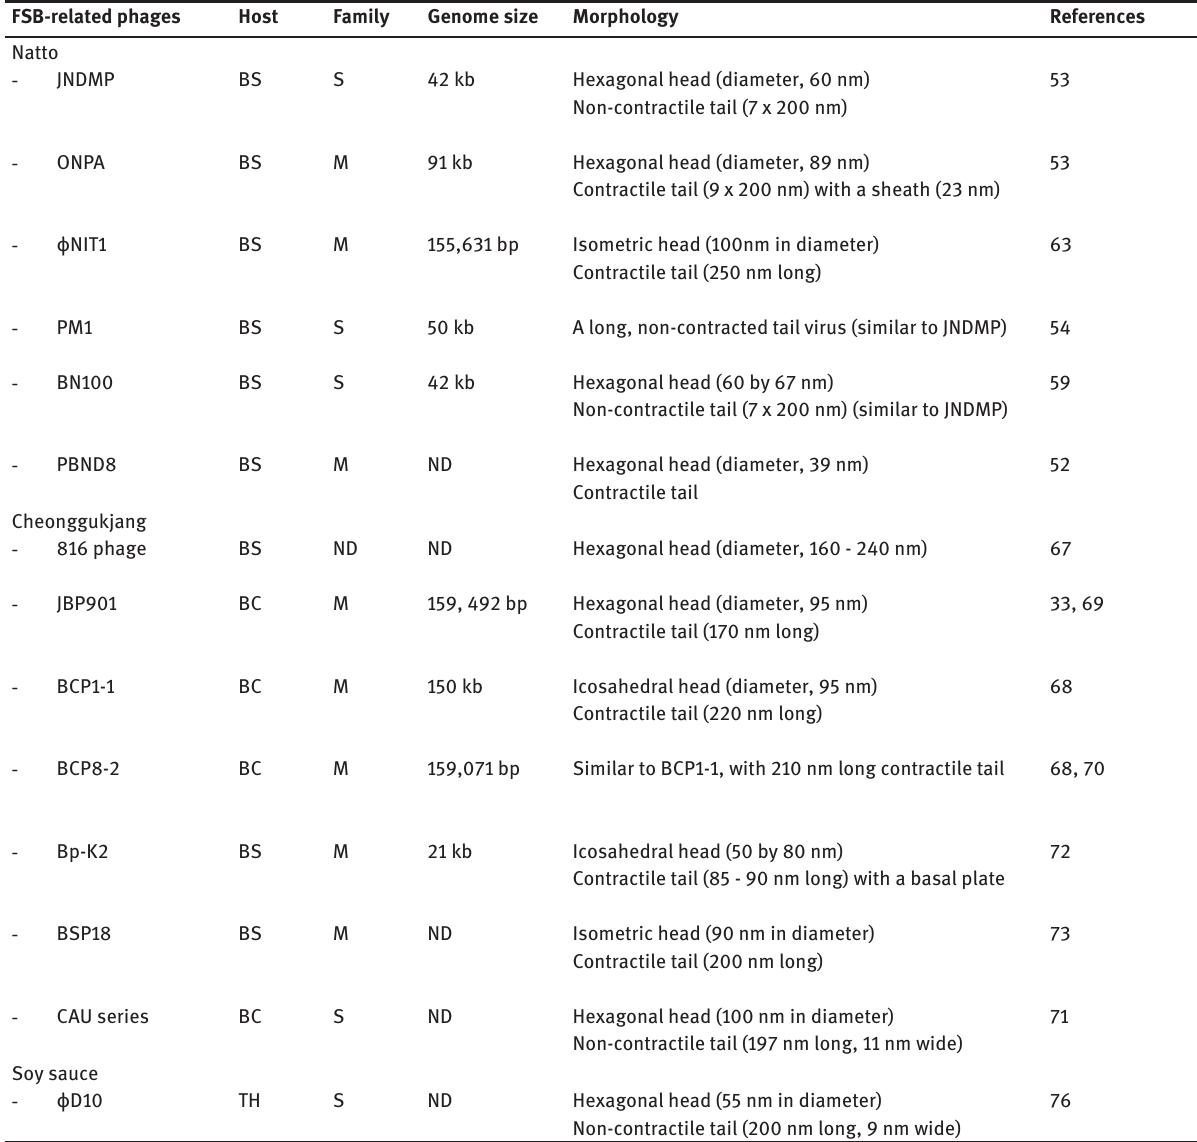
Table 4: Detailed characteristics of FSB-related